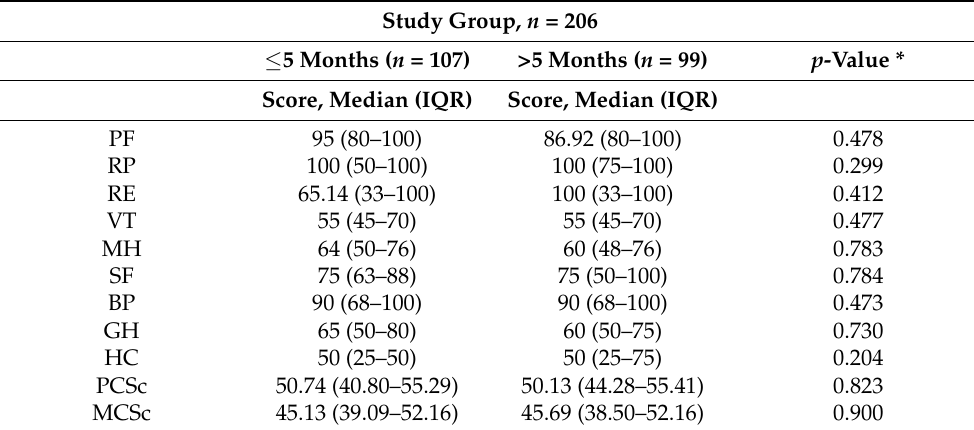
Table 6. SF-36 scores of outpatients who had recovered from COVID-19 at different times: a compari- son between groups.